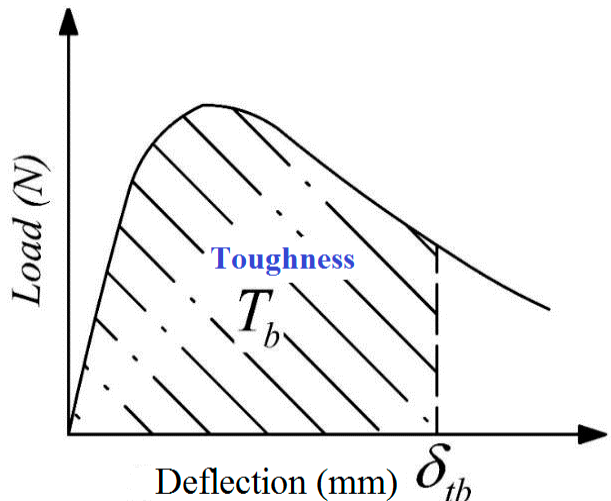
Figure 2. Flexural toughness definition diagram.